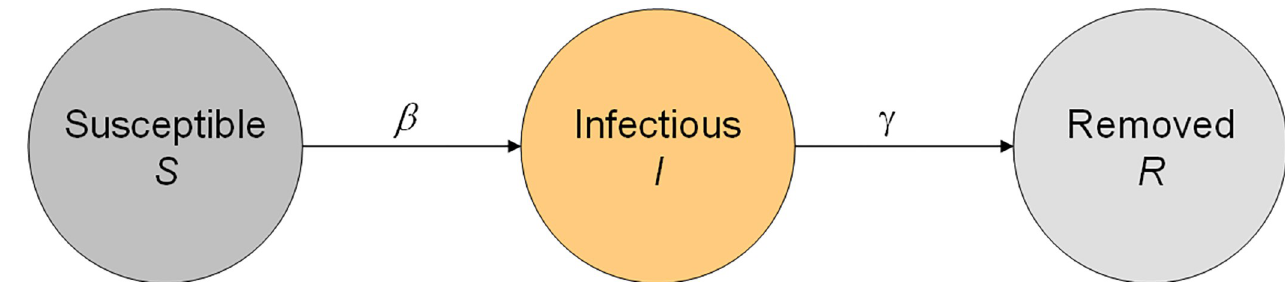
Fig 1. SIR model in infectious disease epidemiology. The population under consideration is divided into three states susceptible (prone to be infected), infected and removed (recovered or